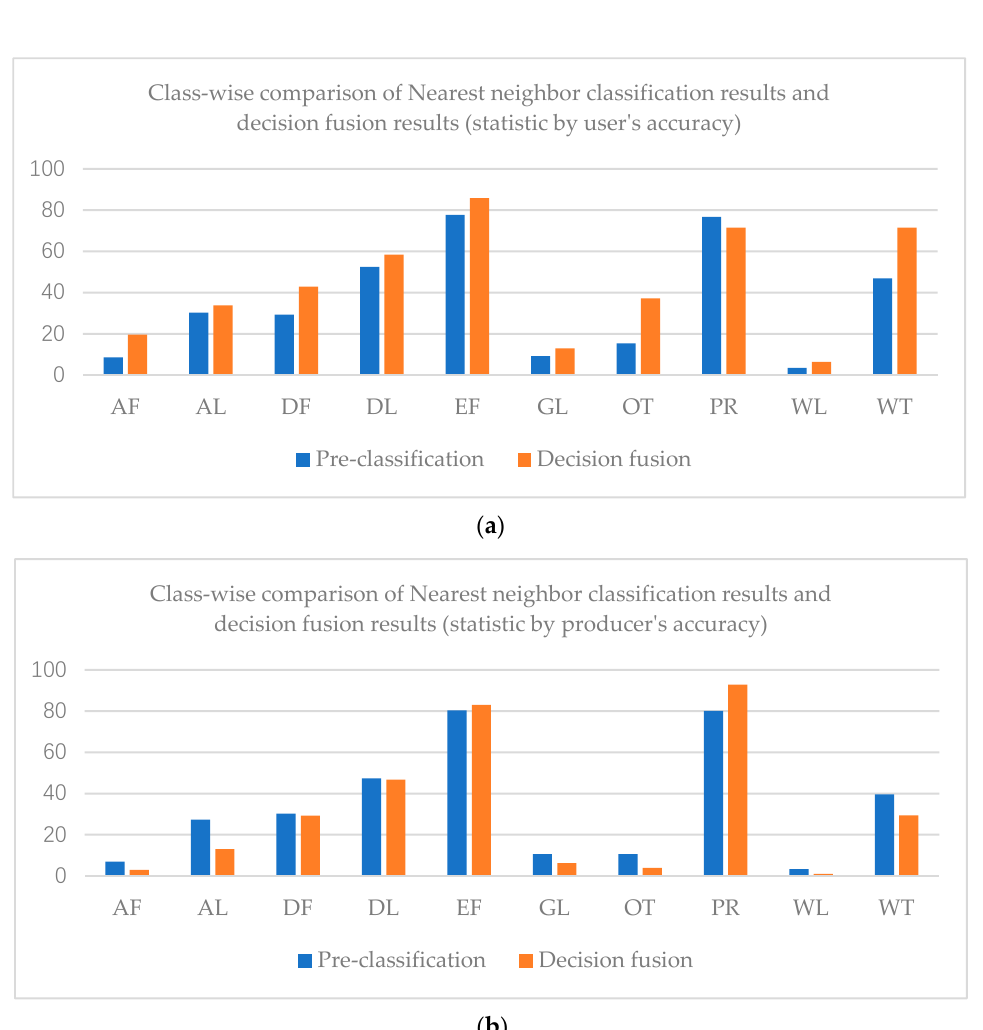
( b ) Figure 8. Confusion matrixes of the Mun River Basin for ( a ) pre-classification results and ( b ) neighborhood spatial rela- tionship and fuzzy classification fusion results.